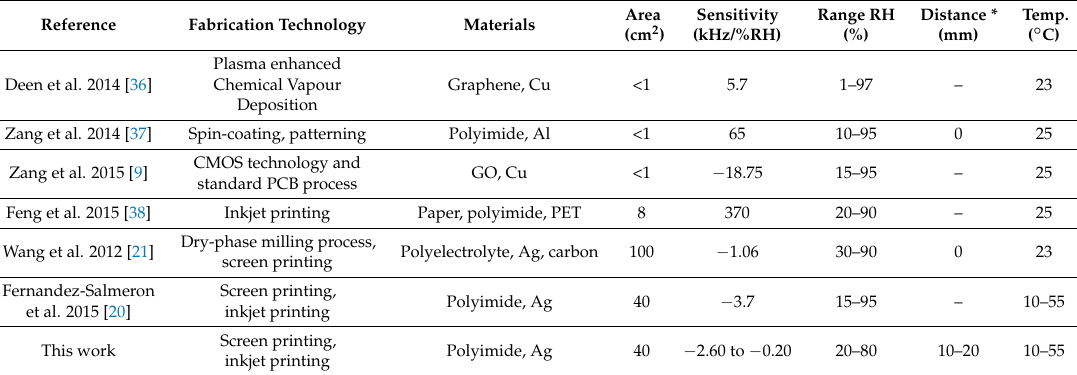
Table 3. Comparison among LC type sensor for humidity monitoring. * Distance between reader and tag antennas. Temp. stands for